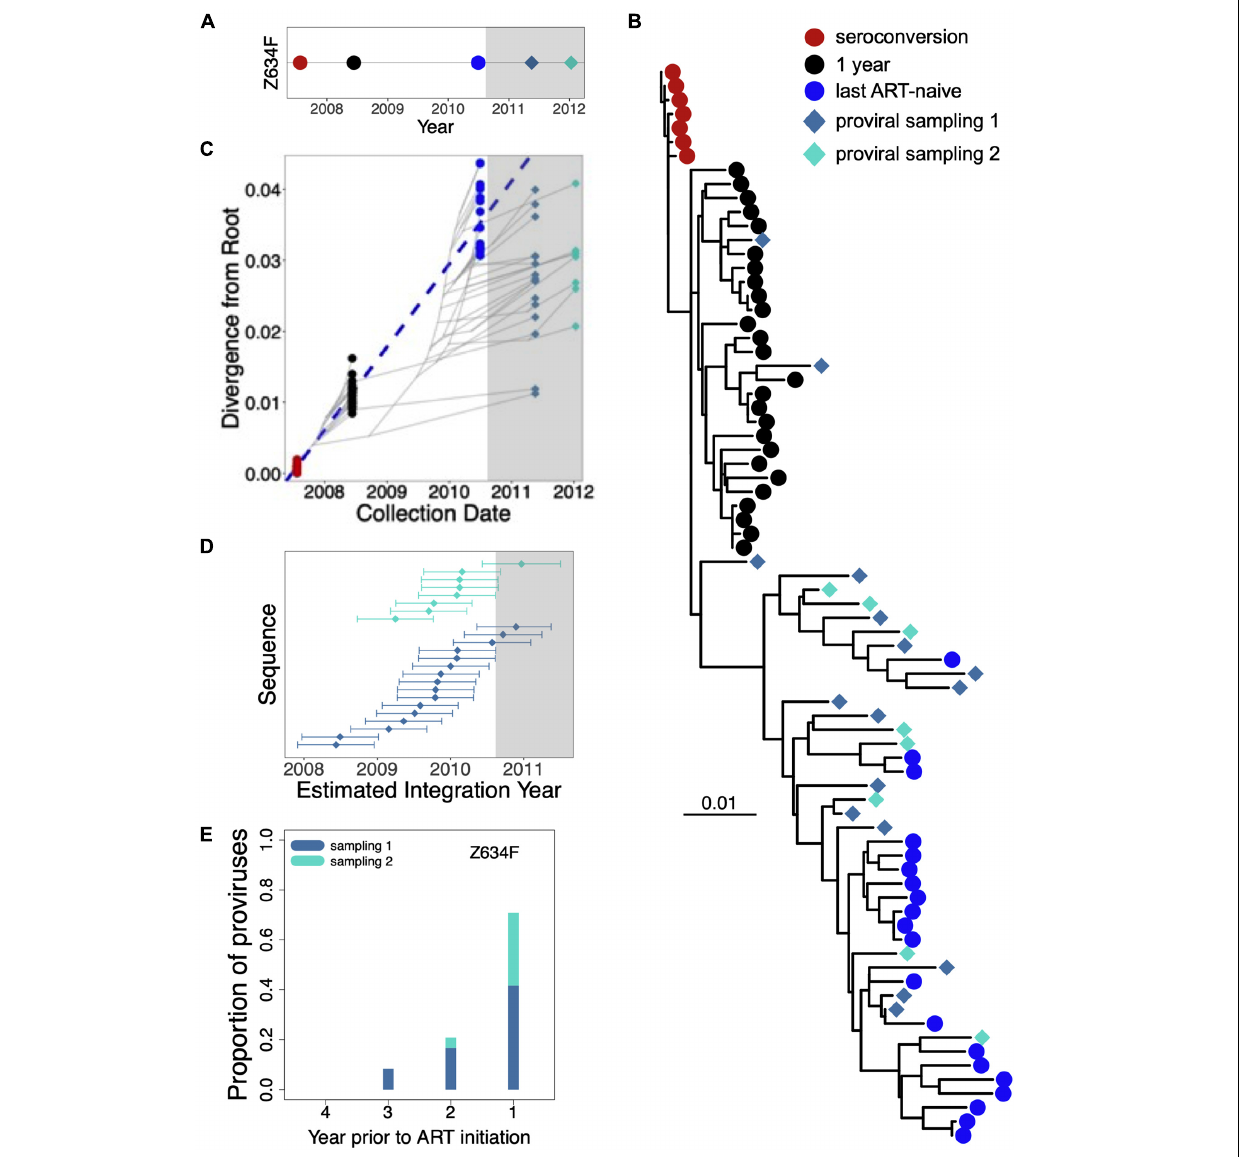
FIGURE 2 | Estimating the ages of proviruses persisting on ART: Participant Z634F. (A) Sampling timeline for participant Z634F. Plasma HIV RNA env sequences were sampled at three time points between infection and ART (colored circles); proviral sequences were sampled twice on ART (colored diamonds). Gray shading denotes ART. (B) Within-host maximum-likelihood phylogeny inferred from intact, distinct HIV sequences, where the root represents the inferred transmitted/founder virus and the symbols at the tree tips denote the sequence type (plasma HIV RNA versus proviral) and sampling time-point. (C) The dashed blue line represents the linear regression relating the root-to-tip distances of the plasma HIV RNA sequences to their sampling times. The slope of the regression line represents the evolutionary rate (ER) of plasma HIV RNA env sequences in this participant during untreated infection (3.2 × 10 − 5 estimated nucleotide substitutions/site/day); this line is used to convert the root-to-tip distances of proviral sequences sampled on ART to their original “creation” (i.e., integration) dates. The faint gray lines represent the underlying evolutionary relationships between sampled HIV sequences. (D) Point estimates and associated 95% CIs of the integration dates of sampled proviral sequences, as inferred from the regression, colored by sampling date. (E) Proportion of Z634F’s proviruses that dated to each year prior to